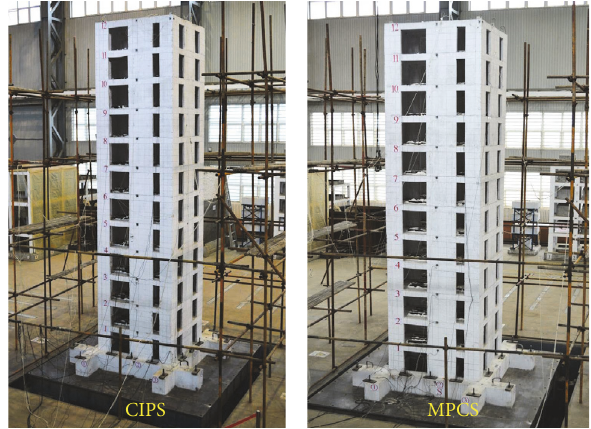
Figure 5: General view of CIPS and MPCS.